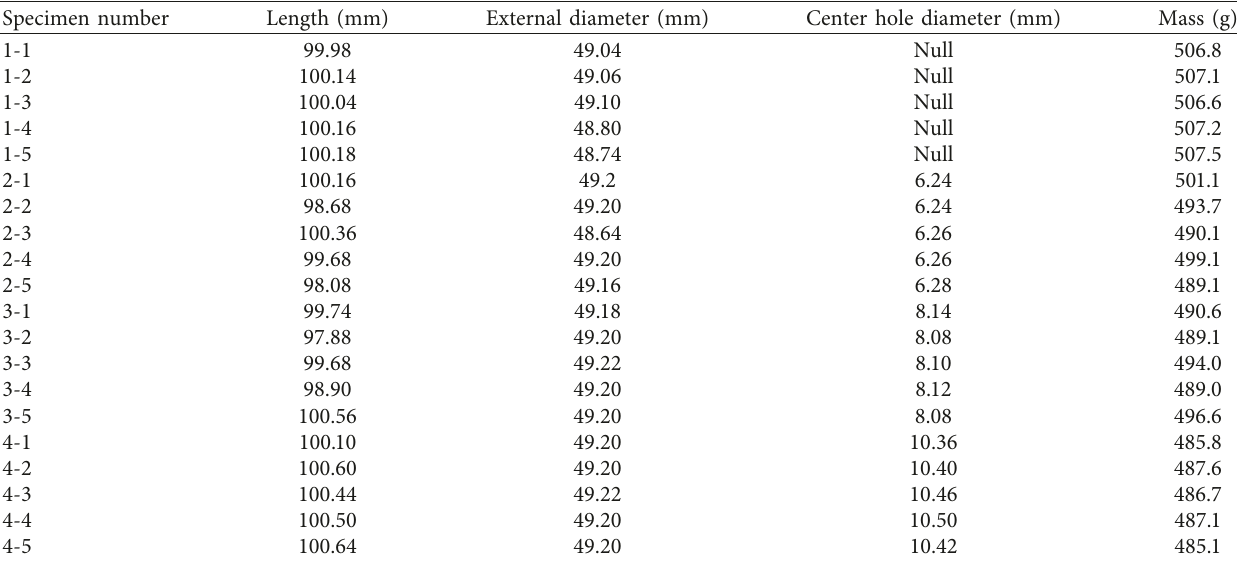
Figure 7: INSTRON 1346 universal material testing machine and diagrammatic sketch of the experimental system. Table 2: Physical parameters of granite